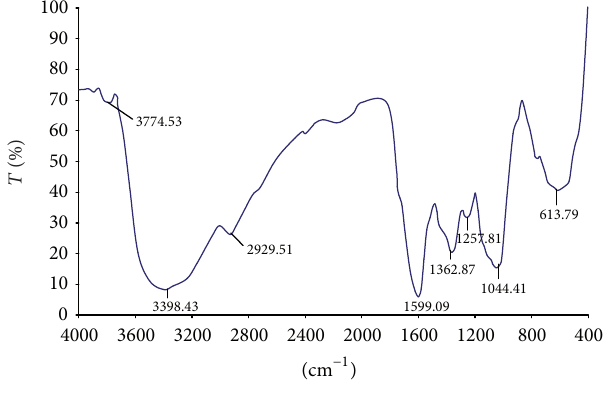
F 1: FTIR of groundnut shell powder.